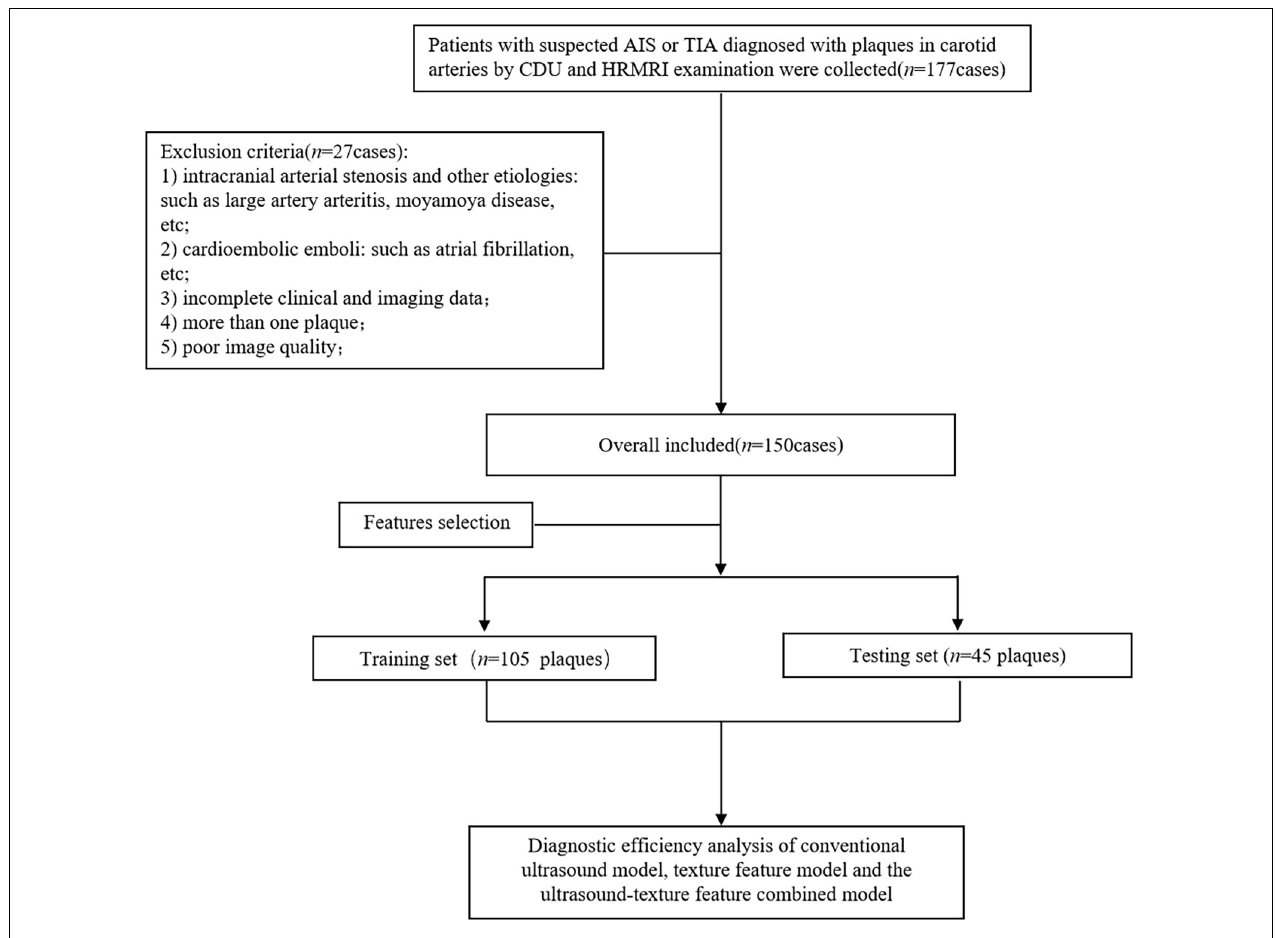
FIGURE 1 | The flowchart of the inclusion and exclusion